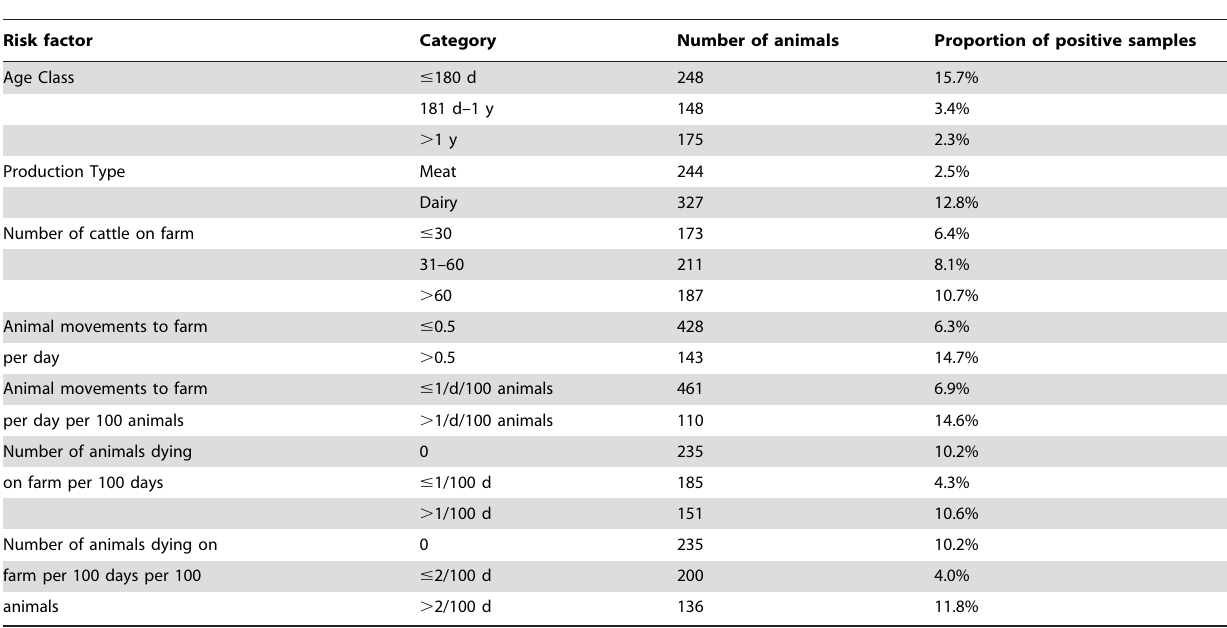
Table 1. Description of risk factors studied in univariate and multivariate logistic regression